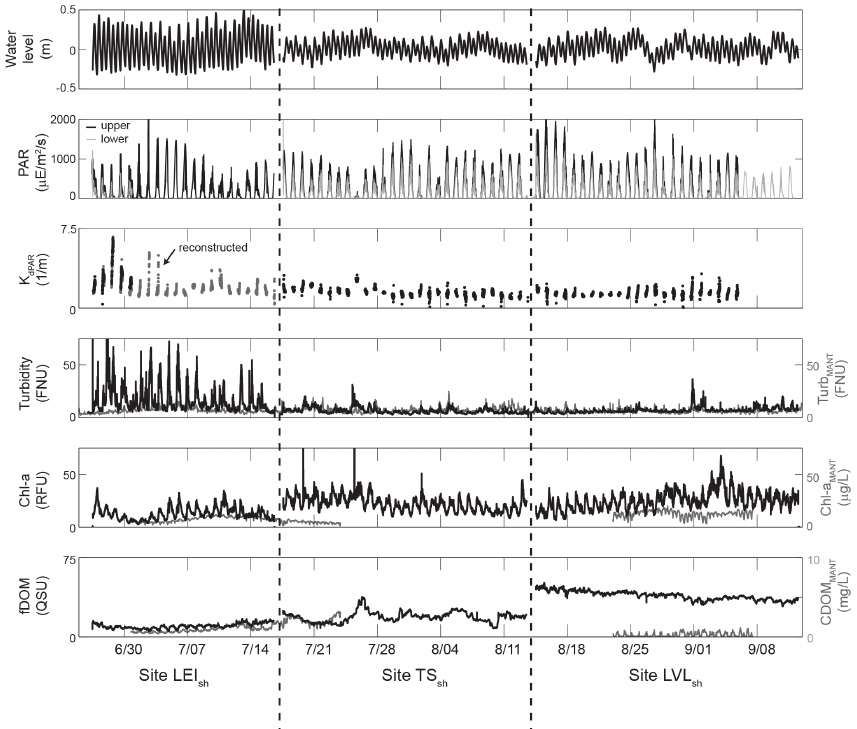
Figure 2. Time series of water level, photosynthetically active radiation (PAR), light attenuation over the PAR spectrum ( K dPAR ) , turbidity, chlorophyll a fluorescence (chl a ), and fluorescing dissolved organic matter (fDOM) for each site, starting from the south on the left. The grey trace in bottom three panels are reference values from site Mantoloking.